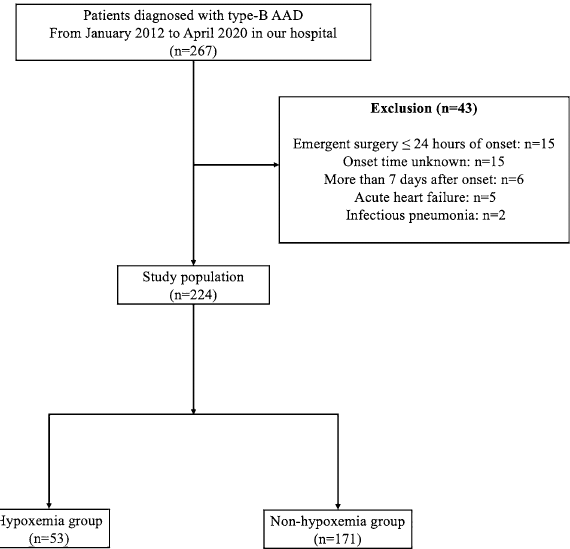
Figure 1. Flow diagram of study patients.